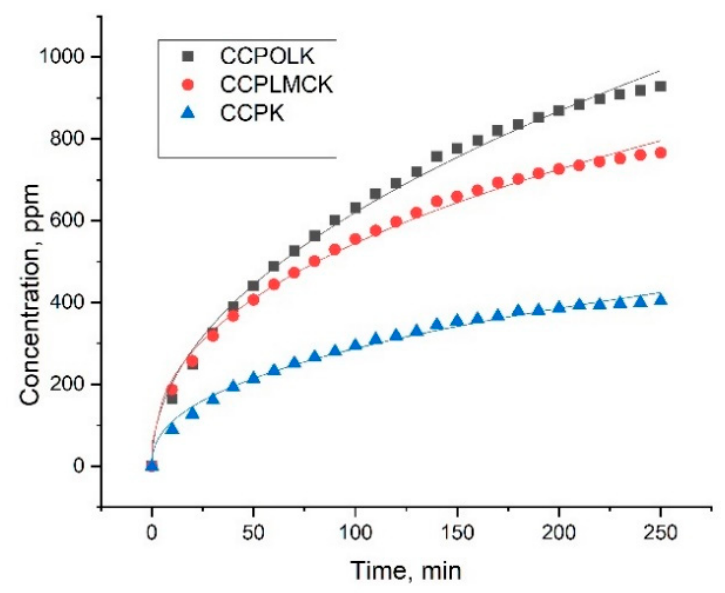
Figure 5. Release profiles of ketoconazole from the investigated samples. Table 4. Kinetic parameters of the drug release from investigated samples.